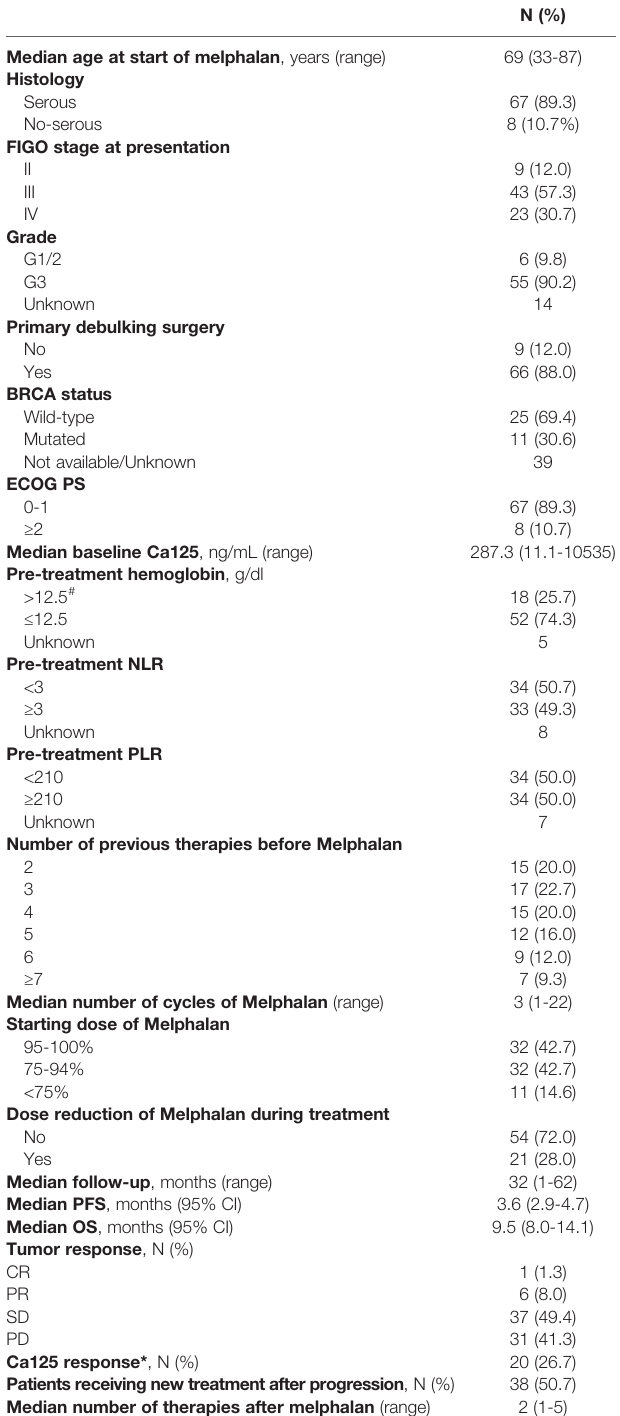
TABLE 1 | Patient